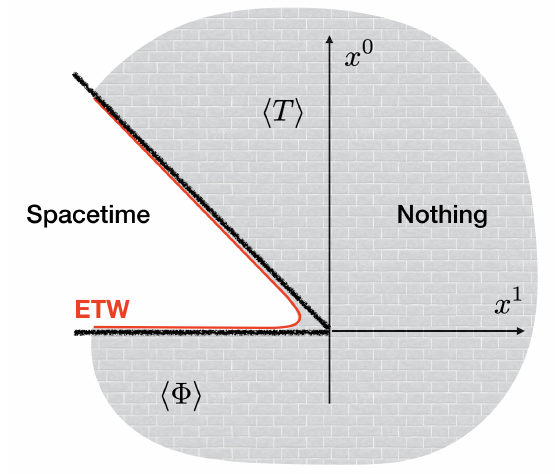
Figure 1 . Depiction of a spacetime slice at which the solutions attain a large fixed field space distance in the tachyon-dilaton space. The asymptotes near x 0 ∼ 0 and x + ∼ 0 , should be regarded as corresponding to the physical location of the ETW branes, which are hence recombined in the middle region, and which for a boundary of spacetime, with nothing beyond them. The spray line signal the location of the